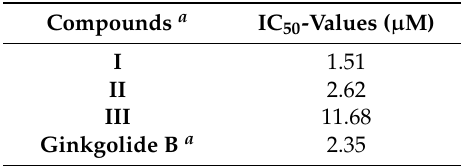
Table 2. Anti-inflammatory Activity of Compounds I – III